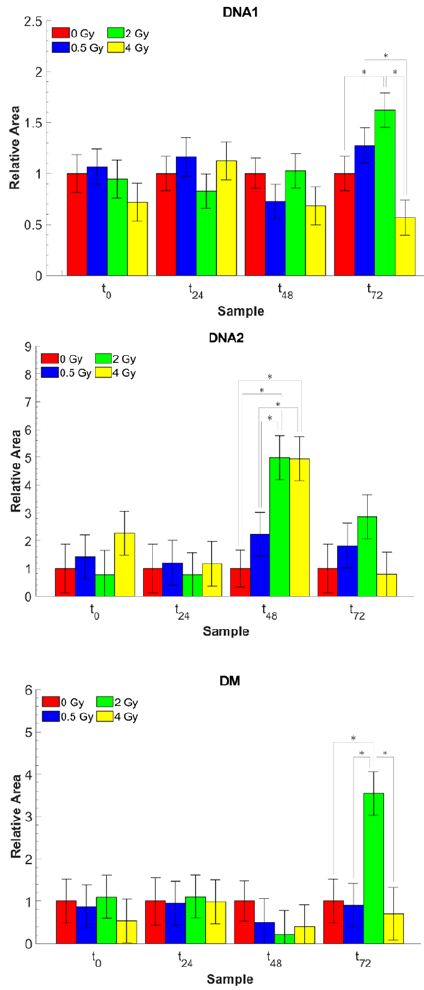
Figure 4. Comparison of the DNA1, DNA2, and DM absorbance area ratios for MCF-10A human breast epithelial cells for different proton doses and different fixation times. See Table 1 for details about the reported ratios (Mean ± SD), which are normalized to the corresponding ratio value of the non-exposed sample. Asterisks indicate significant differences ( p < 0.05).